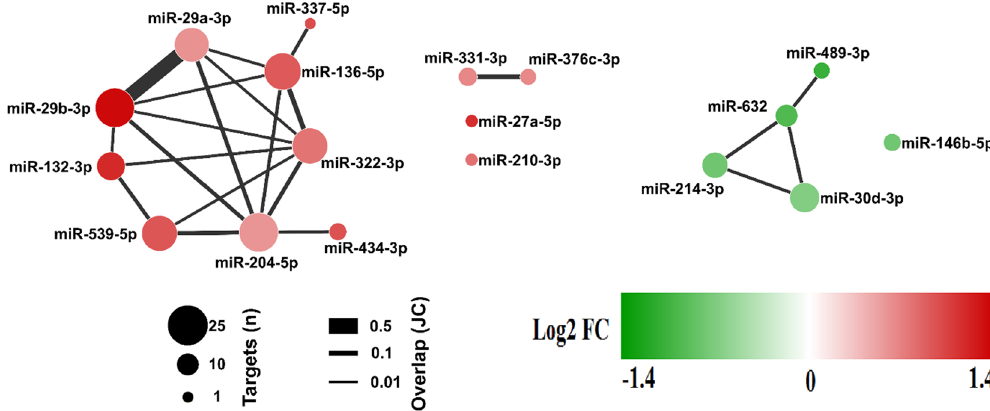
Figure 4. Two distinct sub-networks miRNA-mRNA deregulated in cardiac cachexia. We identified 222 deregulations between 18 miRNAs and 177 target genes. The solid lines connecting molecules represent miRNA-mRNA interaction. Node size represents number of targets for each miRNA, edge width denotes overlap between miRNAs measured by the Jaccard coefficient (JC), and nodes are colored based on the log2 fold change of the differential expression of the miRNA. The interaction network showed two smaller deregulated subnetworks that are clearly separate: one with 8 up-regulated miRNAs (in red) and the other with 4 down- regulated miRNAs (in green) and each miRNA has multiple targets.